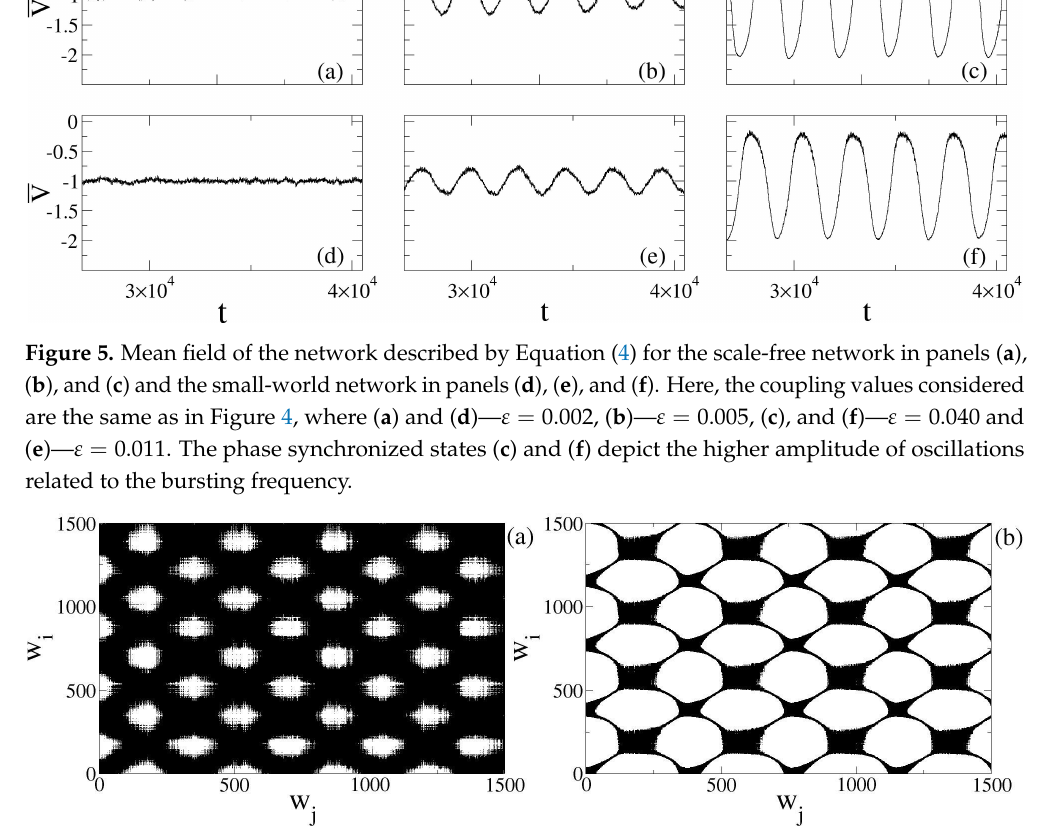
Figure 6. Recurrence plot obtained from the mean field of the network through Equation (9) for an unsynchronized case (panel ( a )) and a synchronized one (panel ( b )) where diagonal structures on the RP are observed, which leads to a higher value of determinism ( ∆ ) in panel ( b ) than in panel ( a